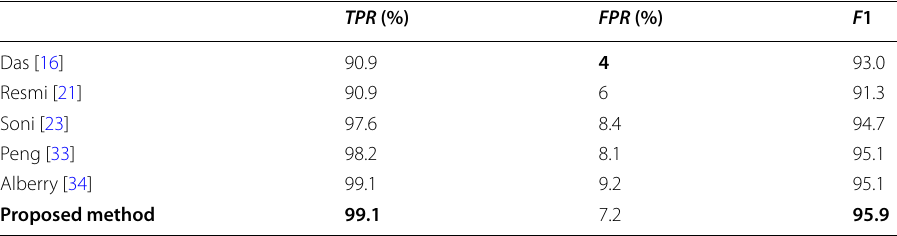
Bold font indicates that the current method has the highest value